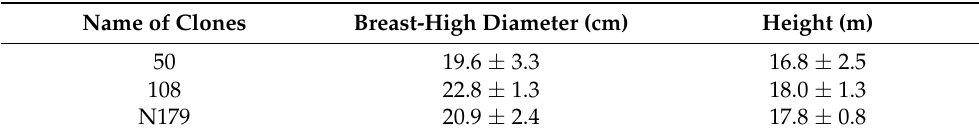
Table 1. Basic information on the experimental materials.